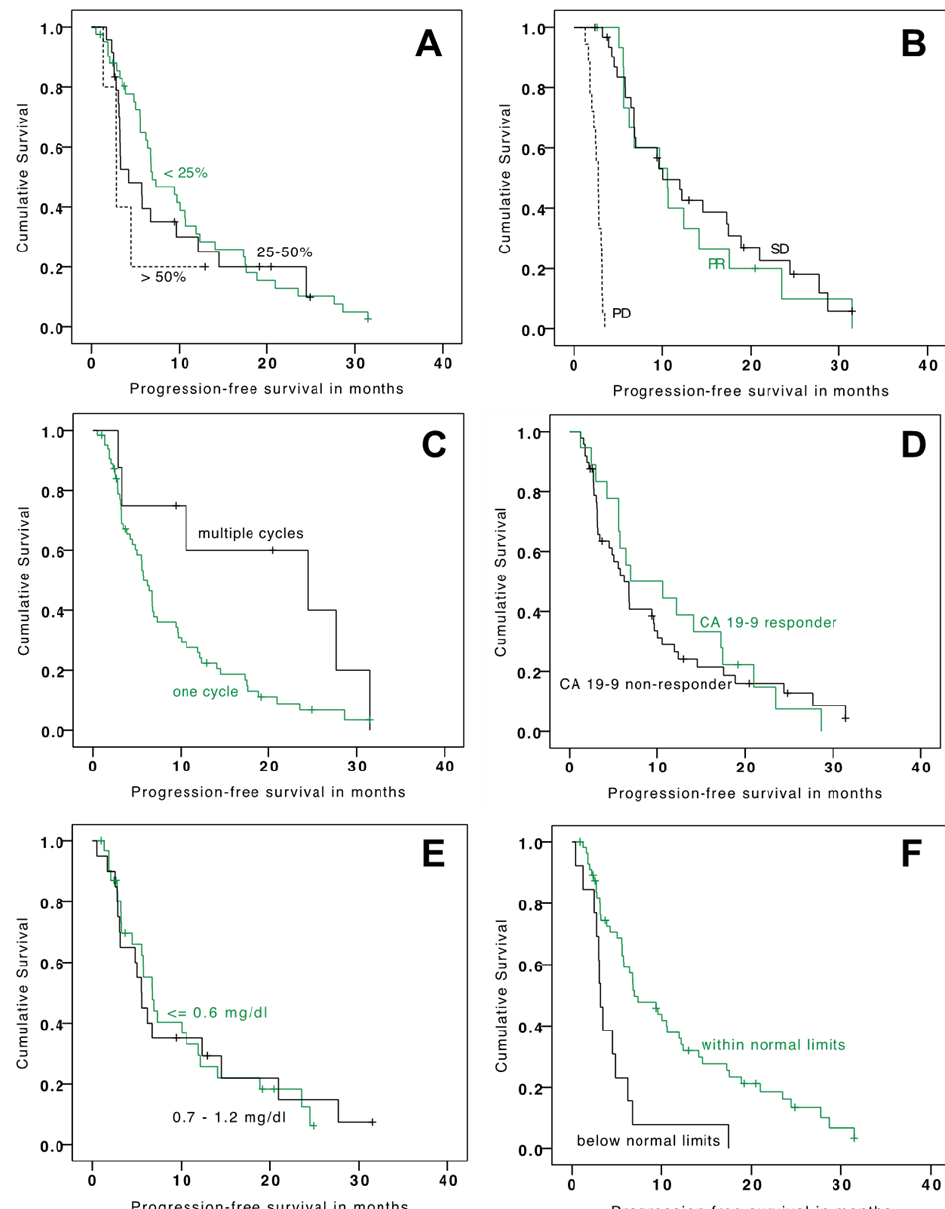
Figure 1. Kaplan-Meier analysis for progression-free survival stratified by tumor burden at baseline ( A ), tumor response ( B ), number of treatment cycles ( C ), CA19-9 response ( D ), baseline levels of bilirubin ( E ), and baseline levels of cholinesterase ( F ).